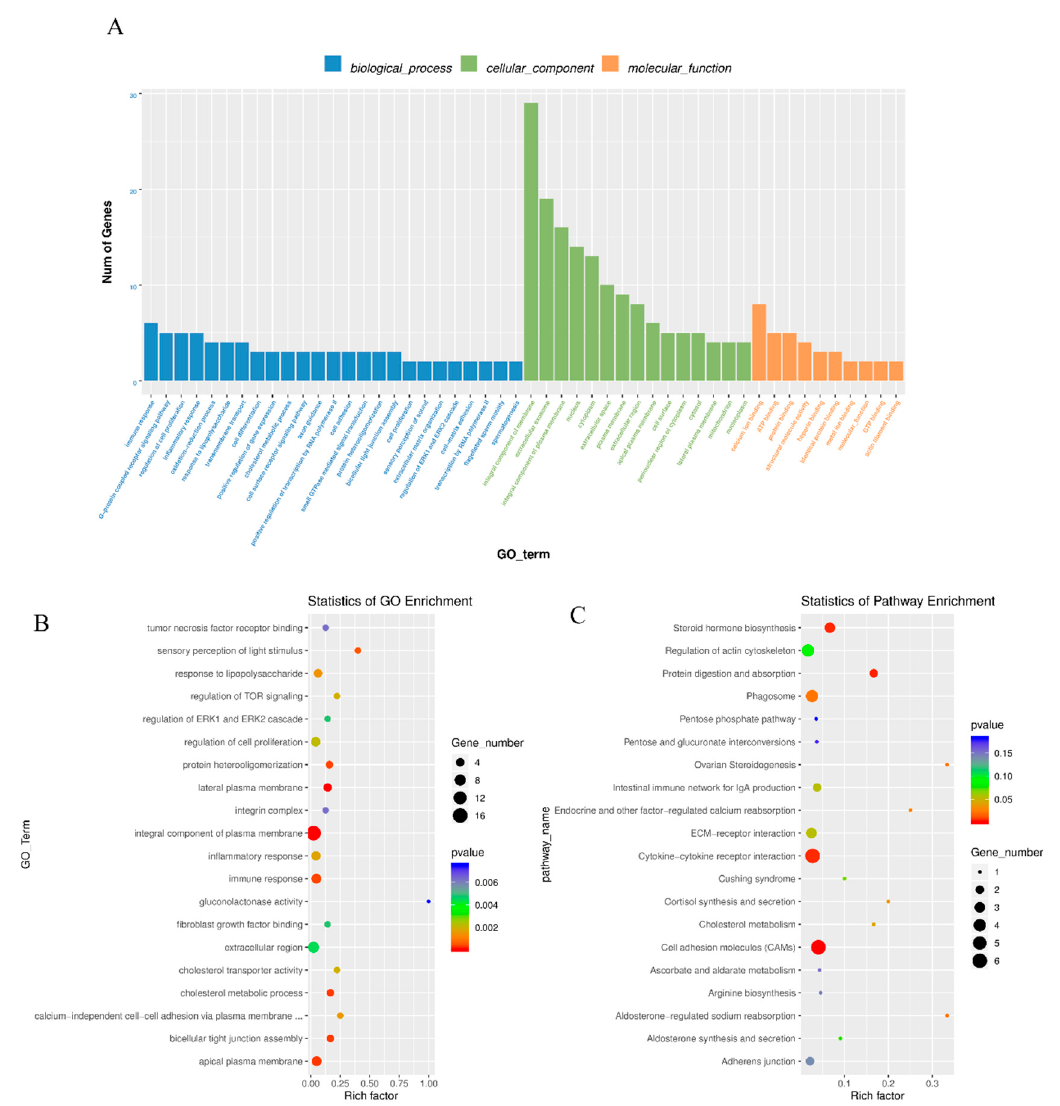
Figure 4. GO and KEGG analysis of differential mRNA expression. ( A ) Histogram of GO enrichment of DE mRNAs. ( B ) Scatter plot of GO enrichment for DE mRNAs. ( C ) Scatter plot of KEGG enrichment for DE mRNAs.